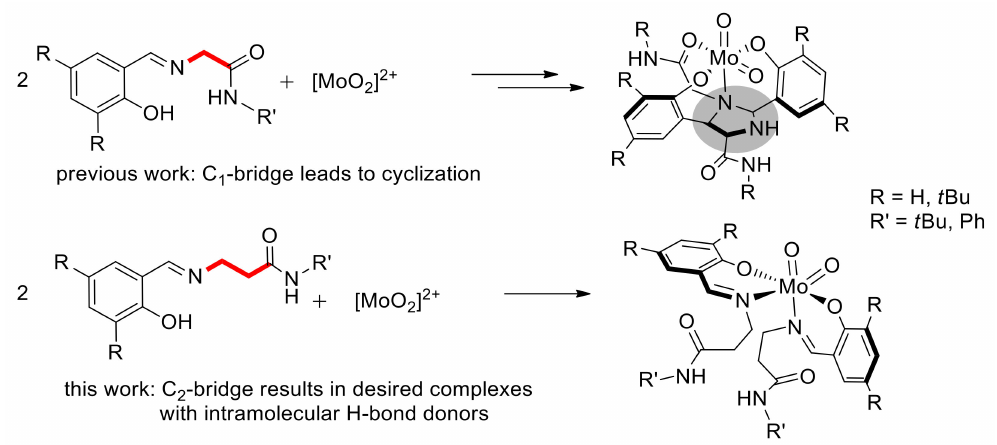
Figure 1. Iminophenolate ligands with amide functionalities featuring a C 1 and C 2 bridge, respectively, and their behavior upon coordination to [MoO 2 ] 2 +